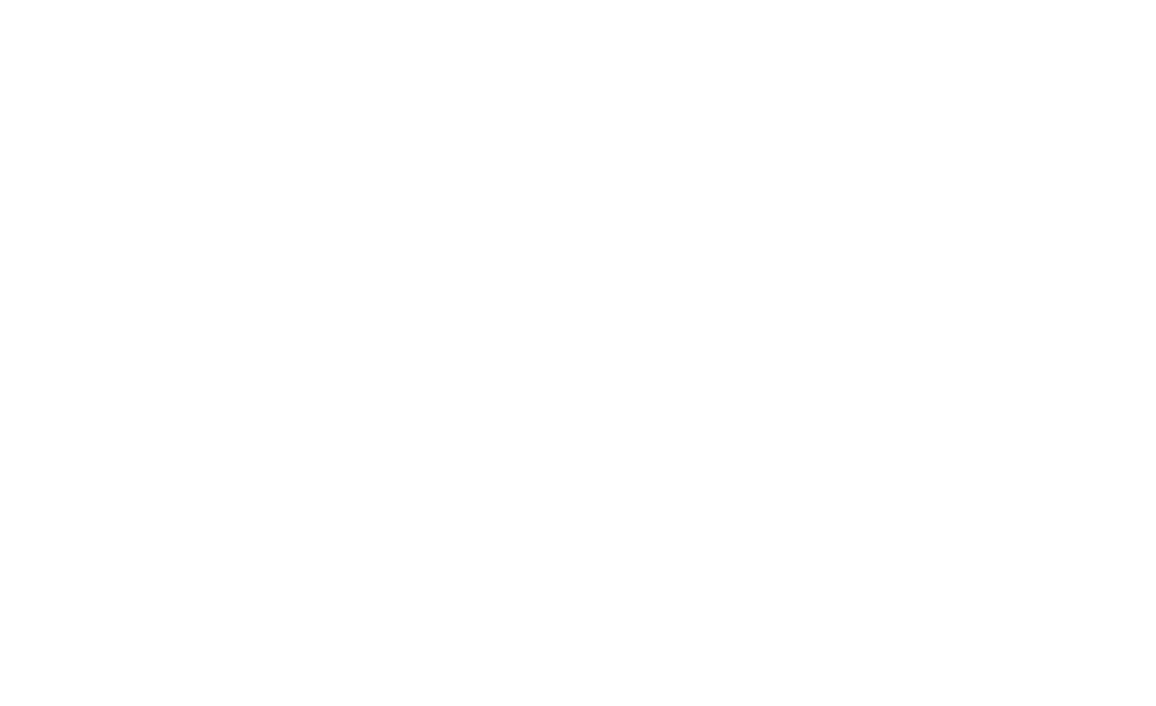
Figure 7. Forest plot of the number of resected lymph